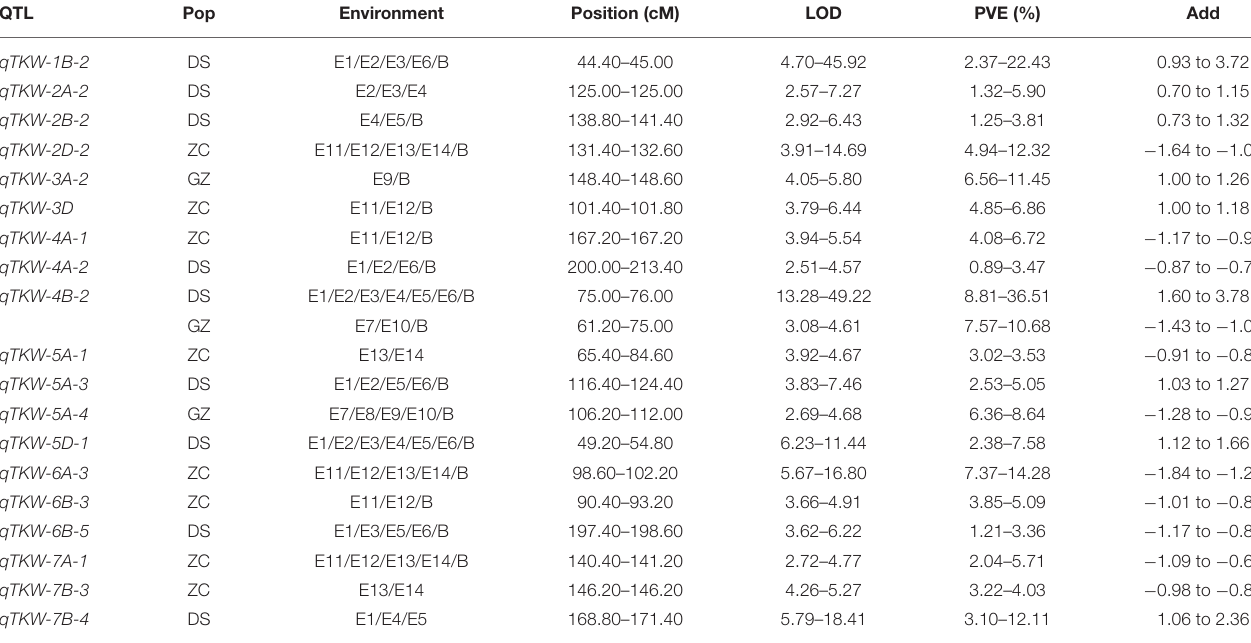
TABLE 5 | Stable QTLs identified for TKW in the three RIL populations, DS, GZ, and ZC using the consensus map.